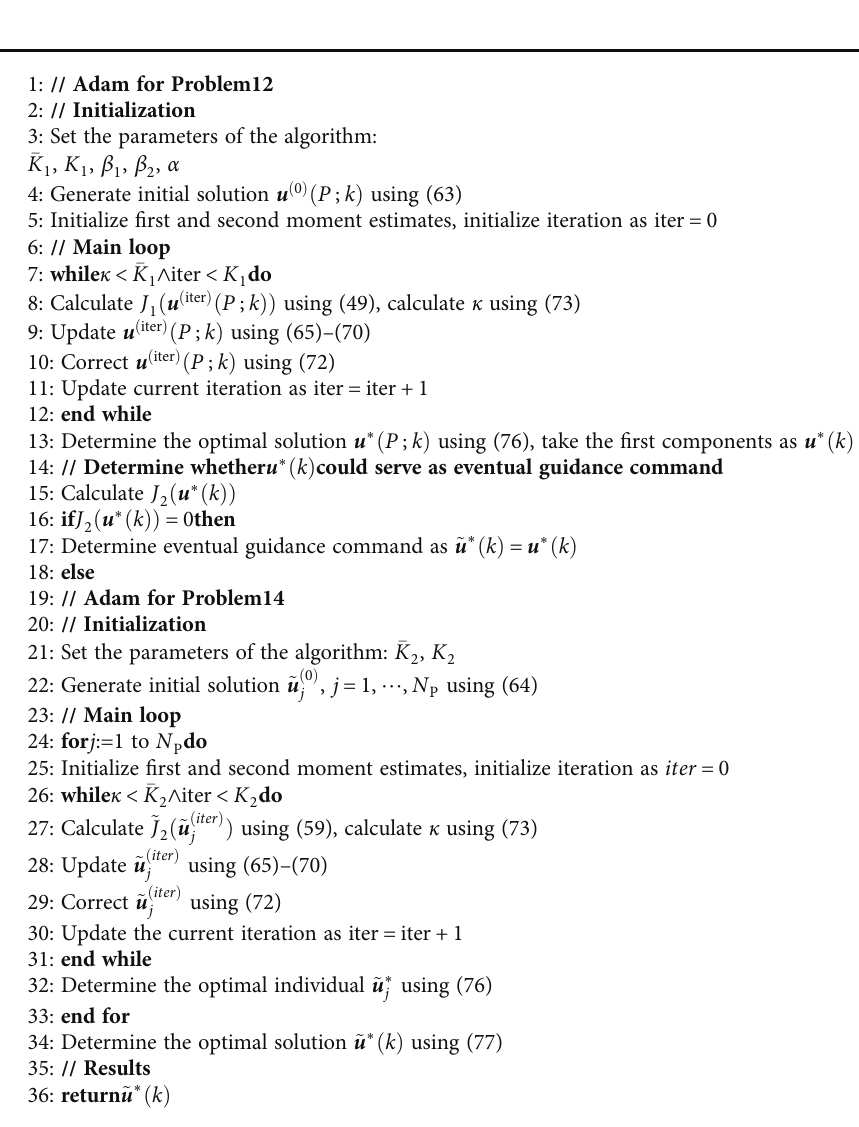
Algorithm 1: Pseudocode of the hybrid